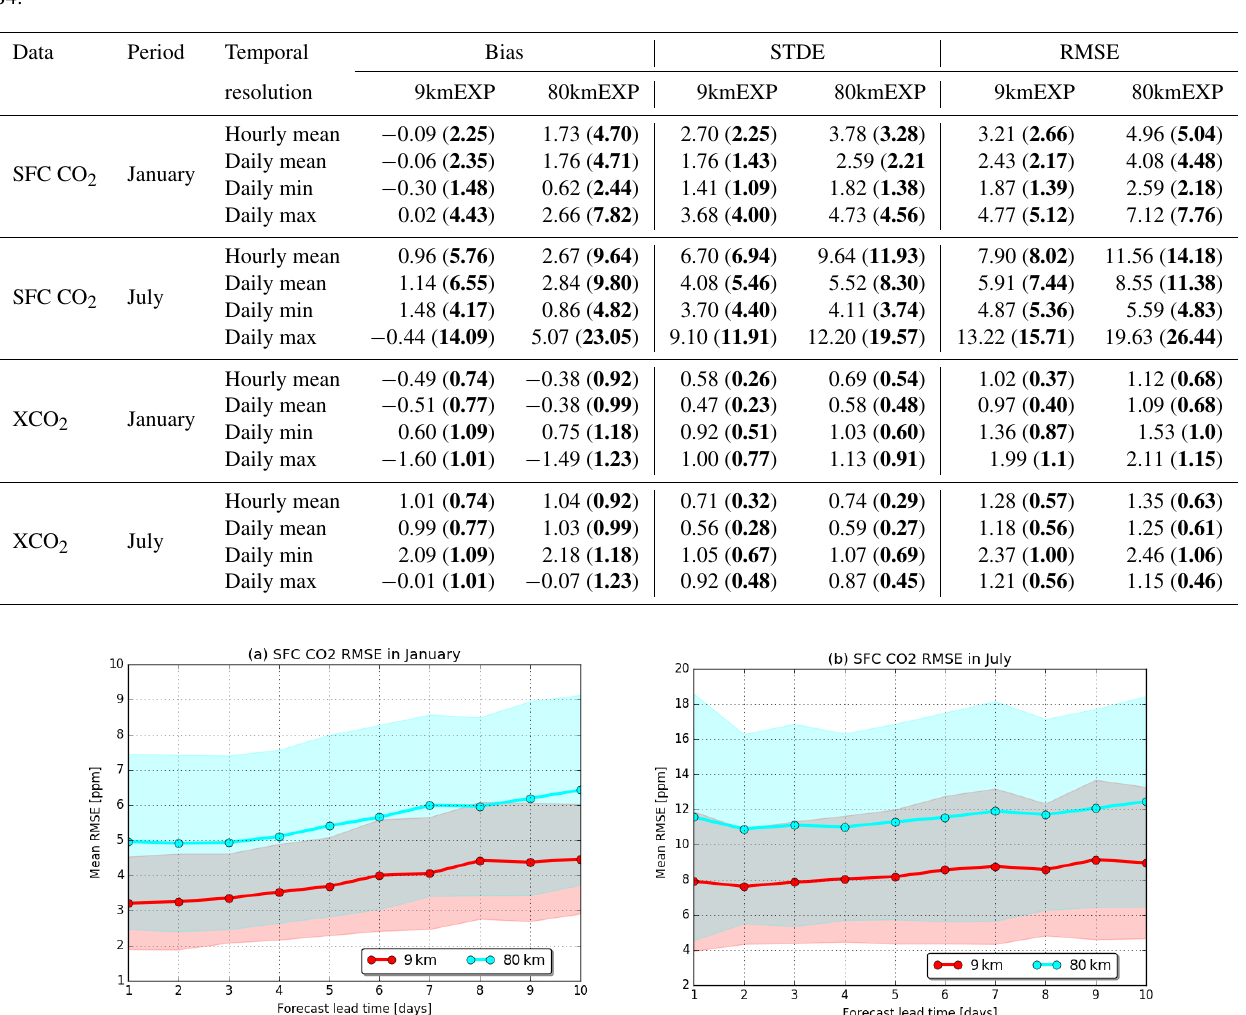
Table 3. Surface CO 2 and XCO 2 mean statistics for bias, STDE and RMSE of all stations and the standard deviation of inter-station statistics (in brackets and bold font) from the highest- and lowest-resolution simulations, i.e. 9kmEXP and 80kmEXP respectively. All the SFC CO 2 stations used in January and July are listed in Tables S1 and S2; the TCCON stations used in the XCO 2 statistics are listed in Tables S3 and S4.